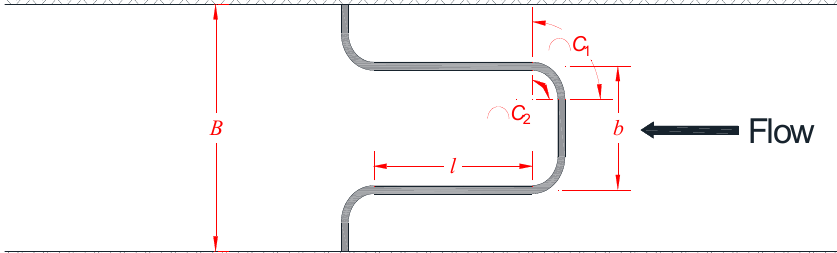
Table 1. Characteristics of the weir models.